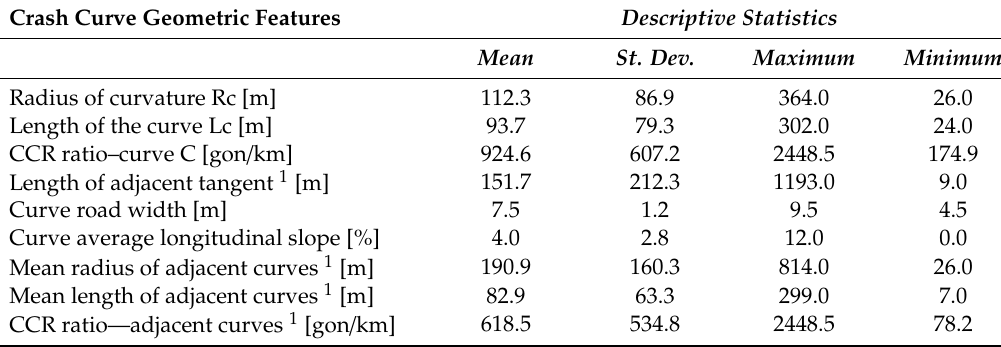
Table 2. Descriptive statistics of the geometric features of ROR FI curved crash sites (each statistic is computed over the total number of curve sites: